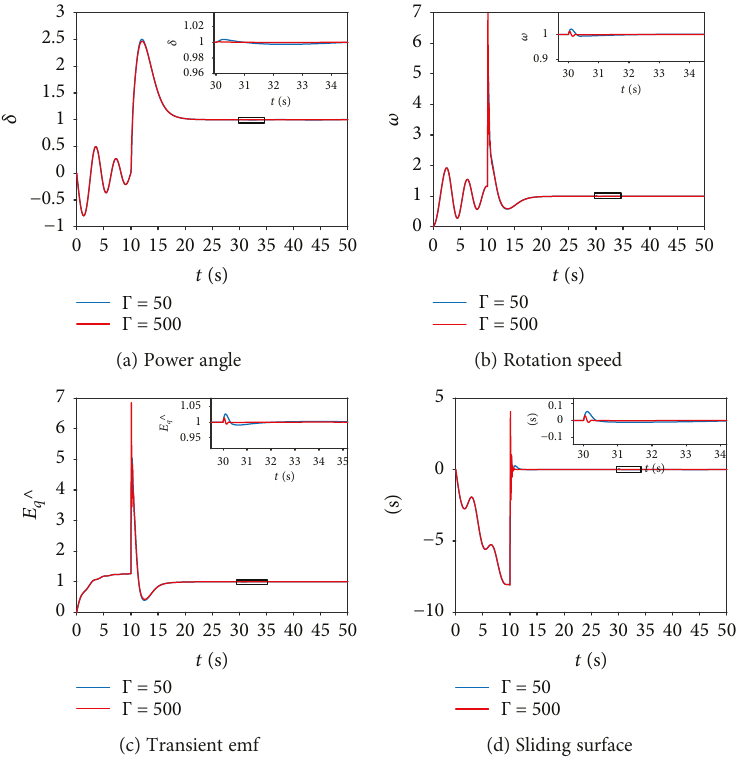
Figure 3: Simulation